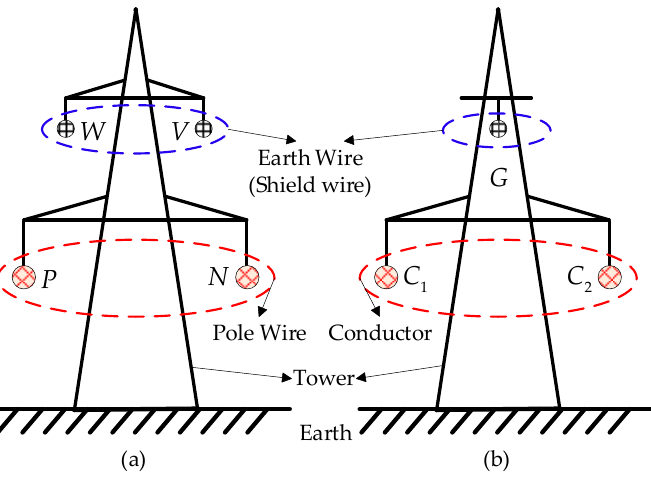
Figure 4. Structure of DC transmission lines: ( a ) Overhead DC line; ( b ) Electrode line.